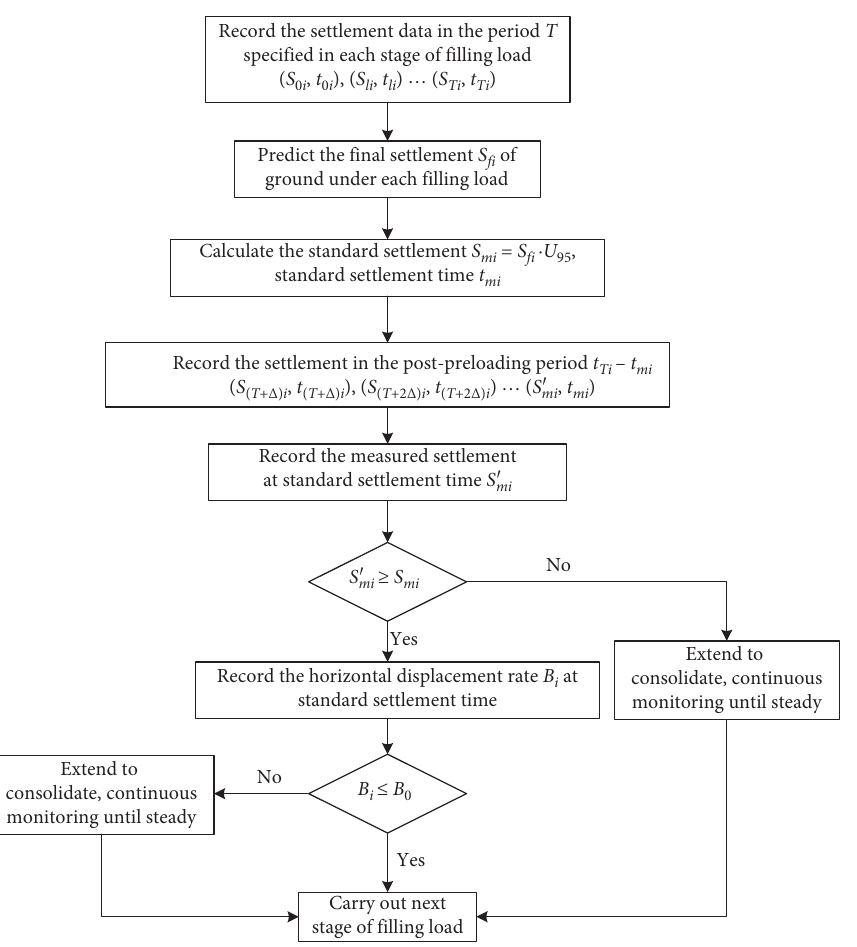
Figure 1: Staged construction conduction